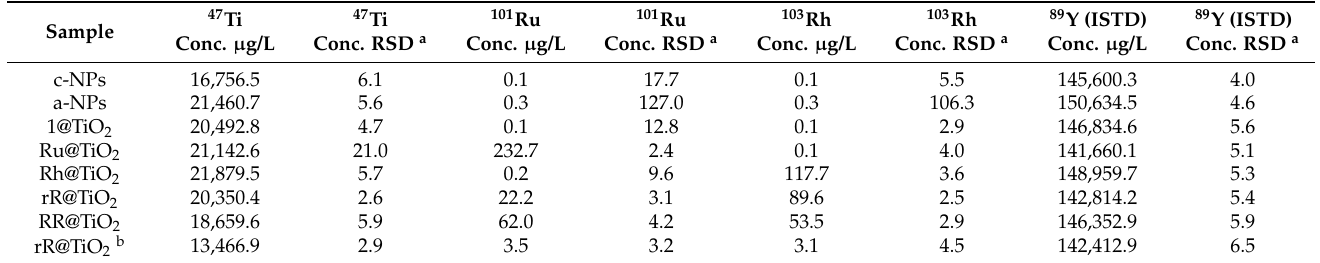
Table 3. ICP-MS concentration and standard deviation of functionalized TiO 2 NPs.